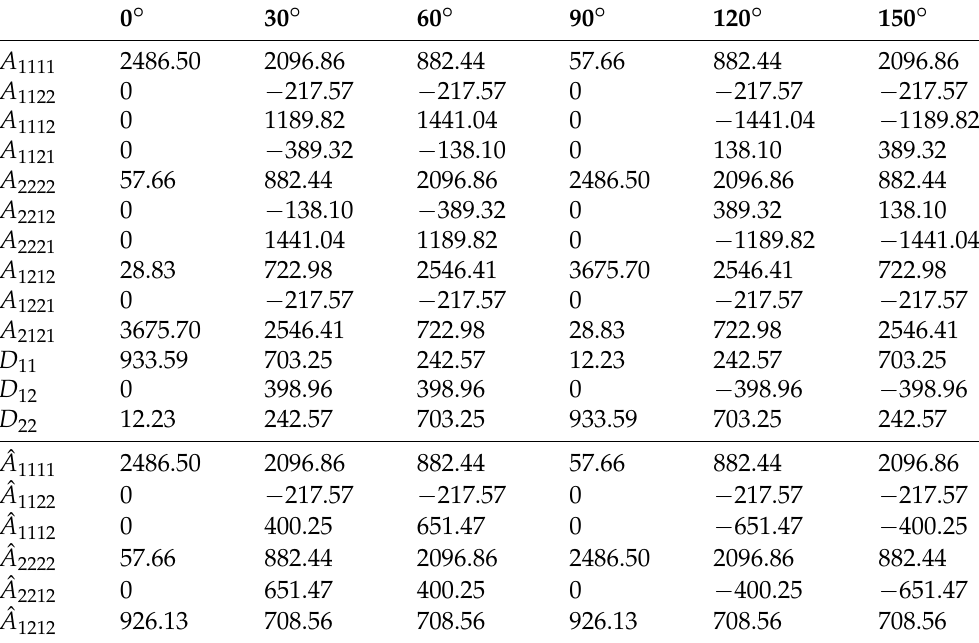
Table 4. Cosserat and Cauchy constitutive parameters for RVE with block parameter ρ = 15,